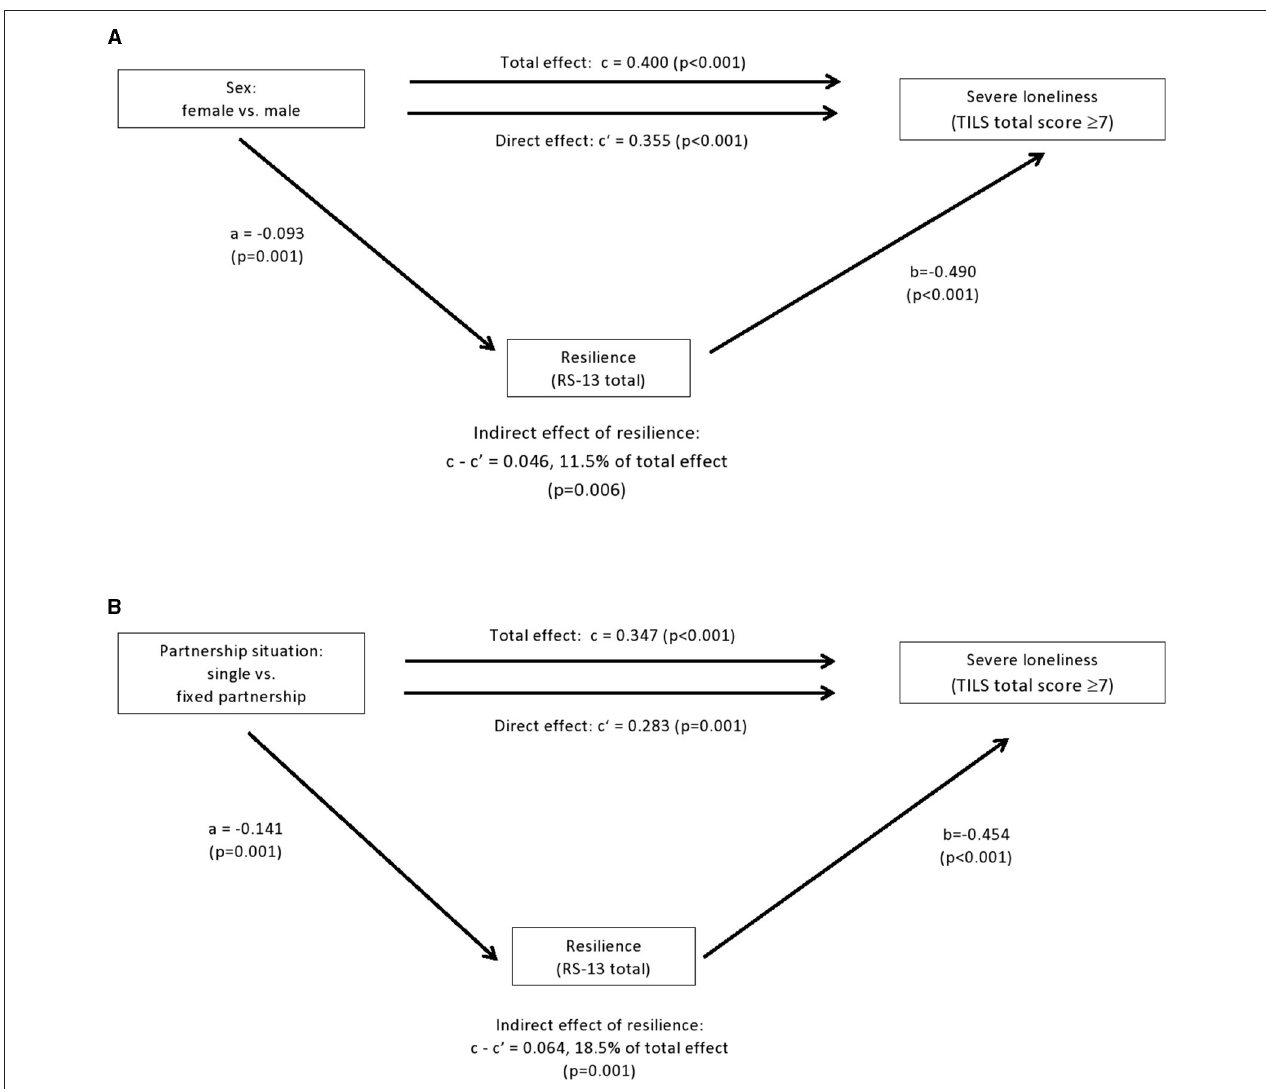
FIGURE 2 | Findings of mediation analyses 2, dependent variable severe loneliness. (A) Effect of resilience on the relationship between sex and severe loneliness. Numbers shown are standardized regression coefficients. Solid lines indicate statistically significant effects. Extraversion (BFI total score) did not show a significant mediation effect. (B) Effect of resilience on the relationship between partnership situation and severe loneliness. Numbers shown are standardized regression coefficients. Solid lines indicate statistically significant effects. Extraversion (BFI total score) did not show a significant mediation effect. TILS, Three Item Loneliness Scale; RS-13, Resilience